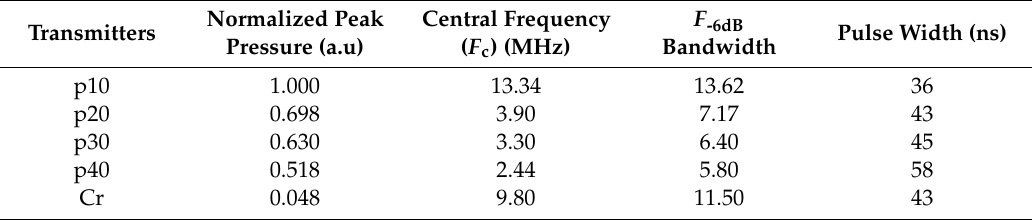
Table 1. Summarized characteristics of the CSNPs–PDMS and reference Cr film